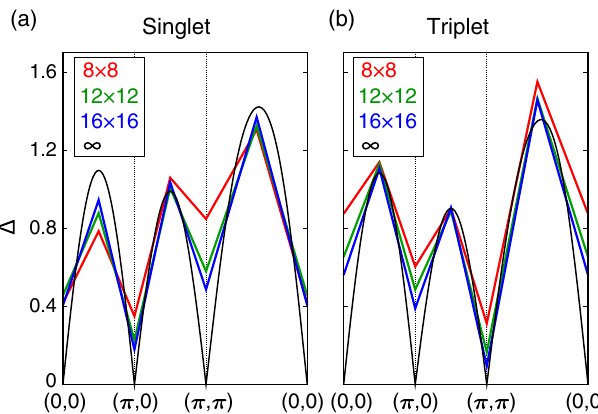
FIG. 5. Low-lying excitation in the QSL phase. (a) Singlet and (b) triplet excitation gap along the symmetric line in the Brillouin zone at J 2 ¼ 0 . 5 . On top of the high-symmetry K points (0,0), ð π ; 0 Þ , and ð π ; π Þ , the excitations at intermediate points ð π = 2 ; 0 Þ , ð π ; π = 2 Þ , and ð π = 2 ; π = 2 Þ are calculated. Black curves are ex- pected dispersions in the thermodynamic limit (see